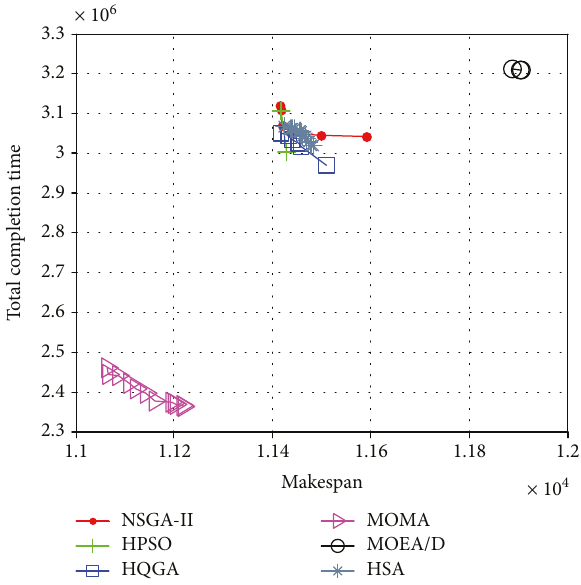
Figure 1: Pareto front of a problem instance for n = 500 , r and α = − 0 152